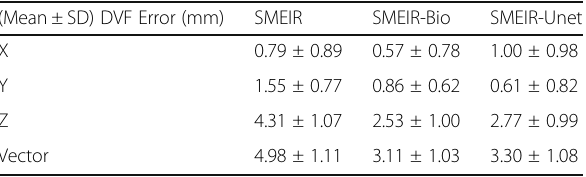
Table 1 Comparison of DVF errors between SMEIR, SMEIR-Bio and SMEIR-Unet